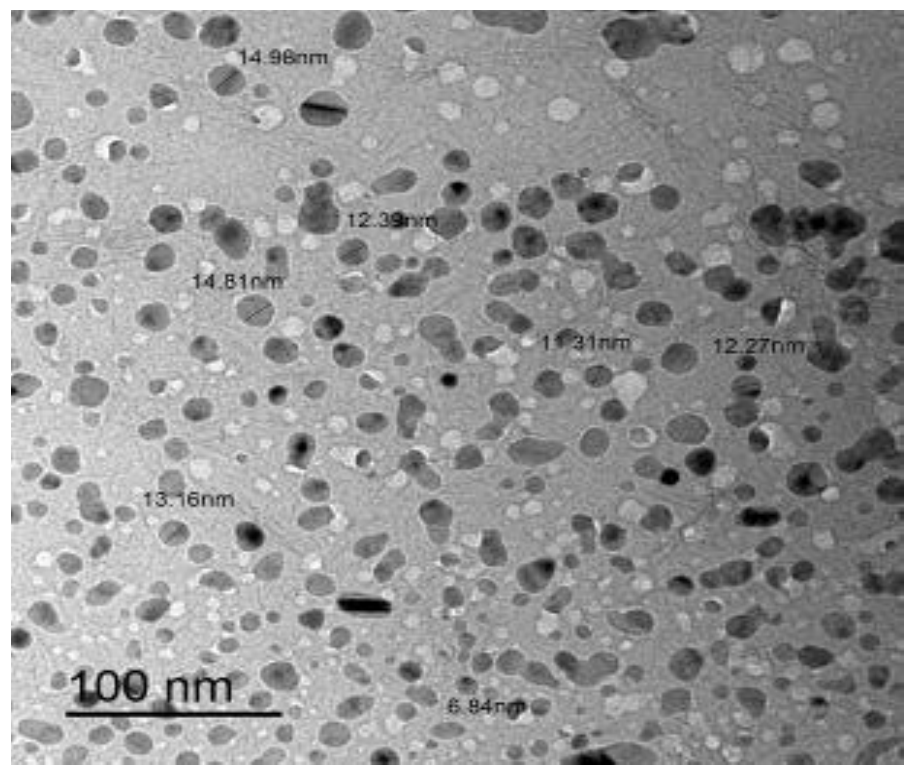
Figure 4. TEM image of Ru III /Q complex.